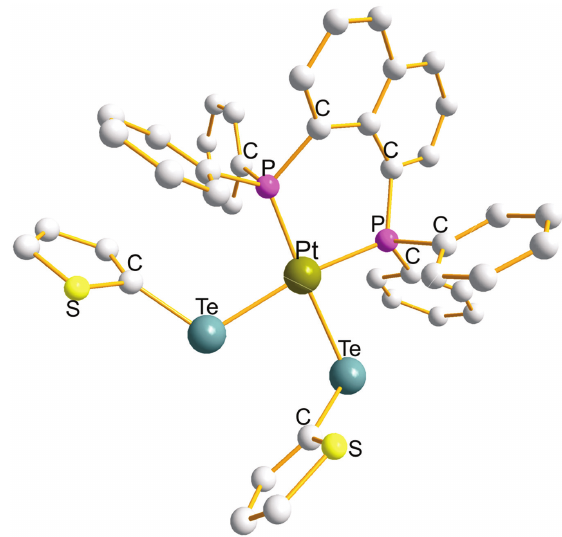
Figure 3: Structure of [Pt{η 2 -Ph (Karjalainen et al., 2017).